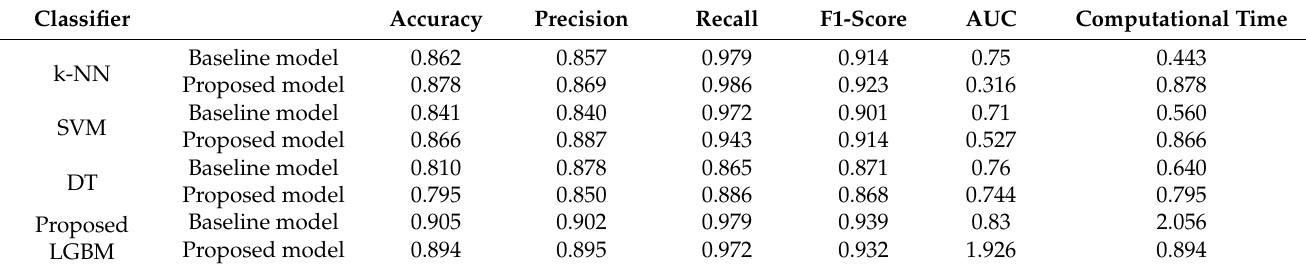
Table 2. Results comparison between baseline model and proposed